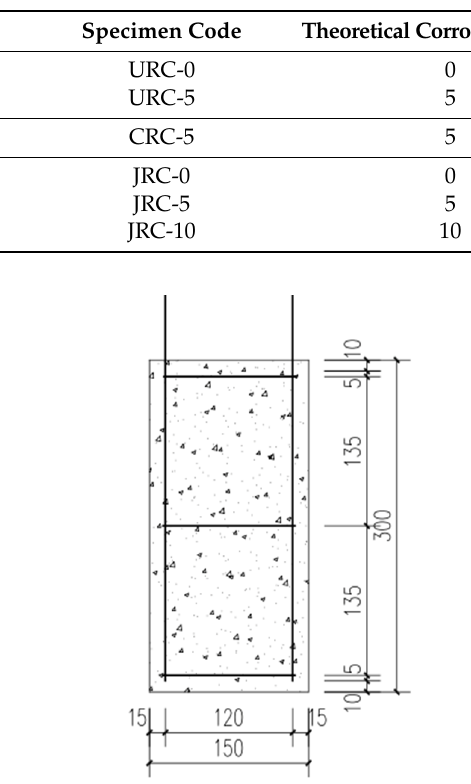
Table 2. Specimen parameters.